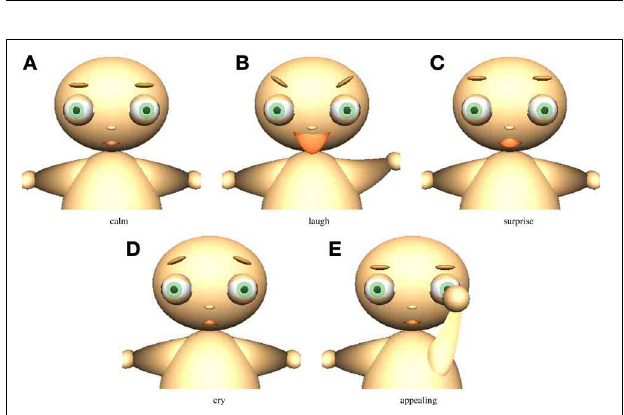
FIGURE 2 | Experimental setup. (A) Virtual agent. (B) Communication scene.